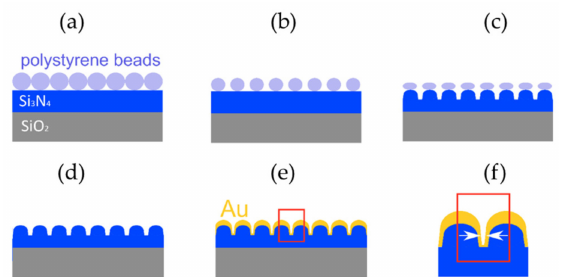
Figure 1. Fabrication process of gold nanodomes. ( a ) Spincoating of polystyrene beads on a Si 3 N 4 chip. ( b ) Thinning down of the polystyrene beads by oxygen plasma. ( c ) Etching of the nanodome pattern in Si 3 N 4 . ( d ) Removal of the remains of the polystyrene beads. ( e ) Gold deposition. ( f ) The arrows